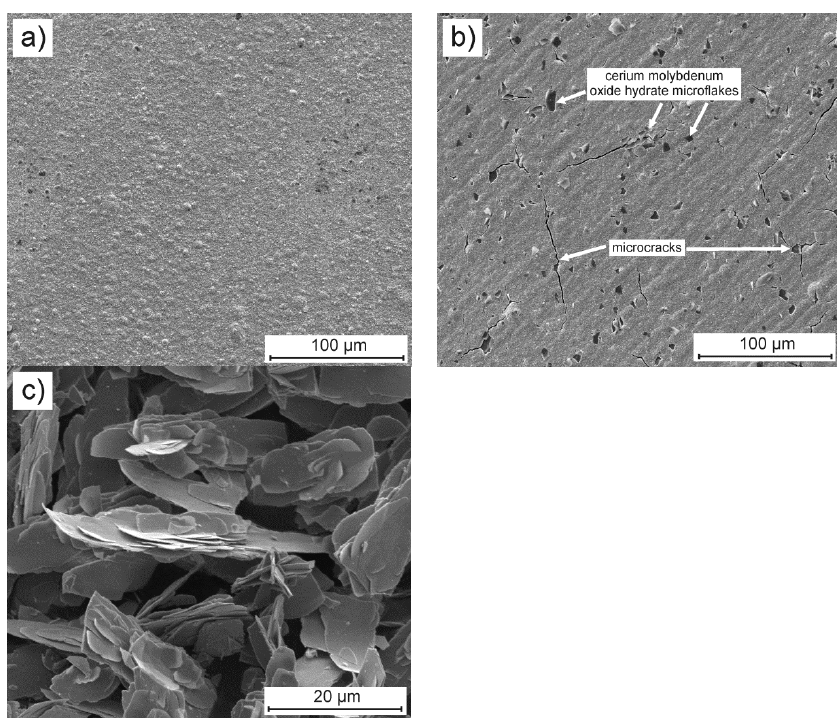
Figure 1. Surface morphology of ( a ) blank and ( b ) composite Ni coatings deposited on the copper substrate at a current density of 6 mA cm − 2 at 70 ◦ C for 1 h, and ( c ) as-synthesized cerium molybdenum oxide hydrate microflakes for comparison. Pictures were recorded in a SE mode of